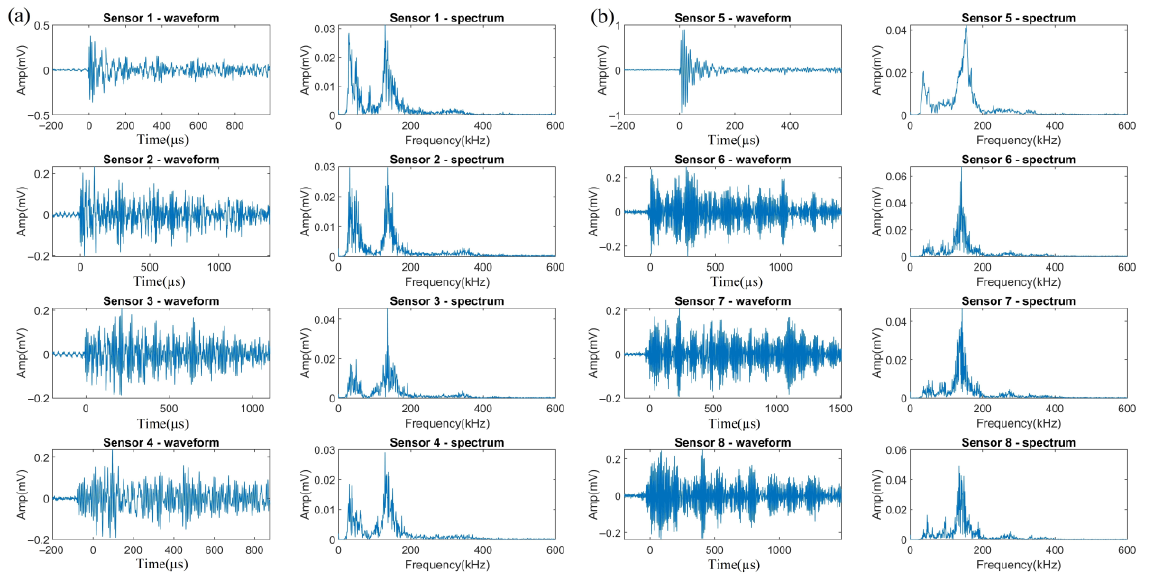
Figure 7. The waveforms and spectrums from the same event of uniform corrosion acquired by ( a ) Nano30 sensors and ( b ) VS150-RIC sensors .